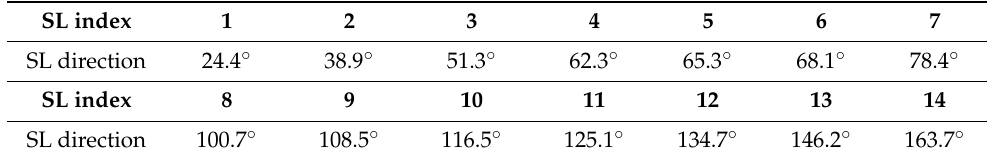
Figure 6. SSL reduction using SSR algorithm for 16-element linear array at: ( a ) δ = 0.05, d n = λ , and C = 11, ( b ) δ = 0.05, d n = 1.5 λ , and C = 6, ( c ) δ = 0.05, d n = 2 λ , and C = 4, ( d ) δ = 0.05, d n = 3 λ , and C = 2. Table 3. Sidelobes indices and the corresponding directions for uniformly fed 16-element linear